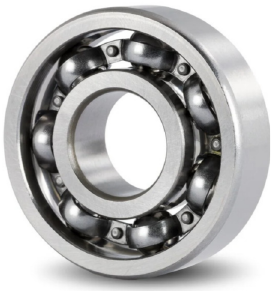
Figure 2. A typical ball-bearing [19].